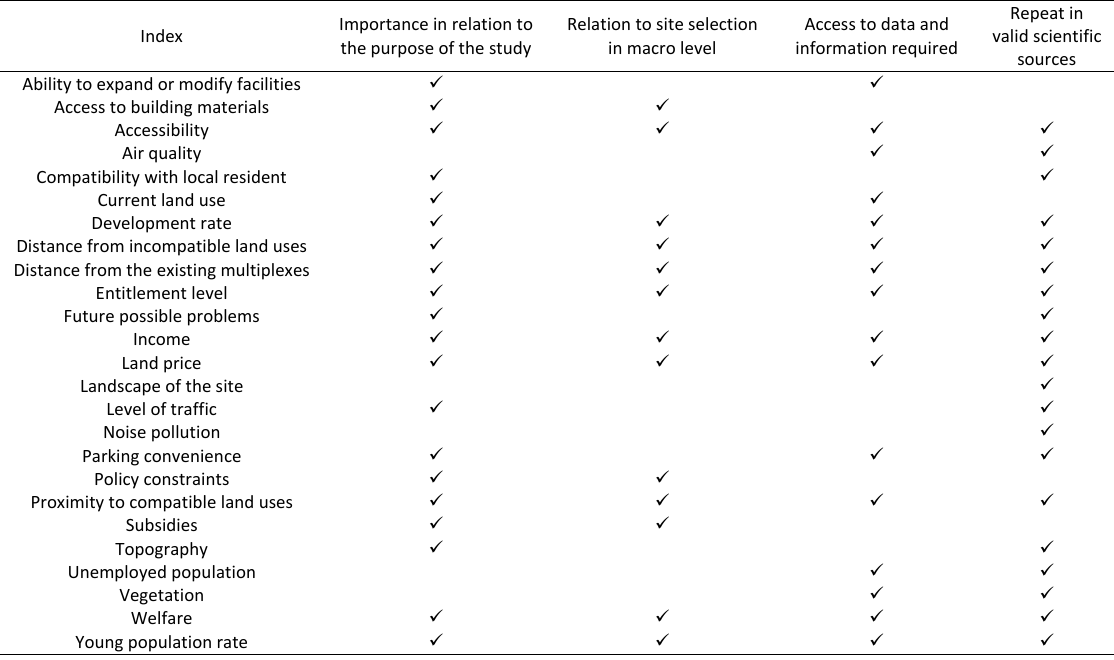
Table 1: Review of 25 initial indices derived from various sources